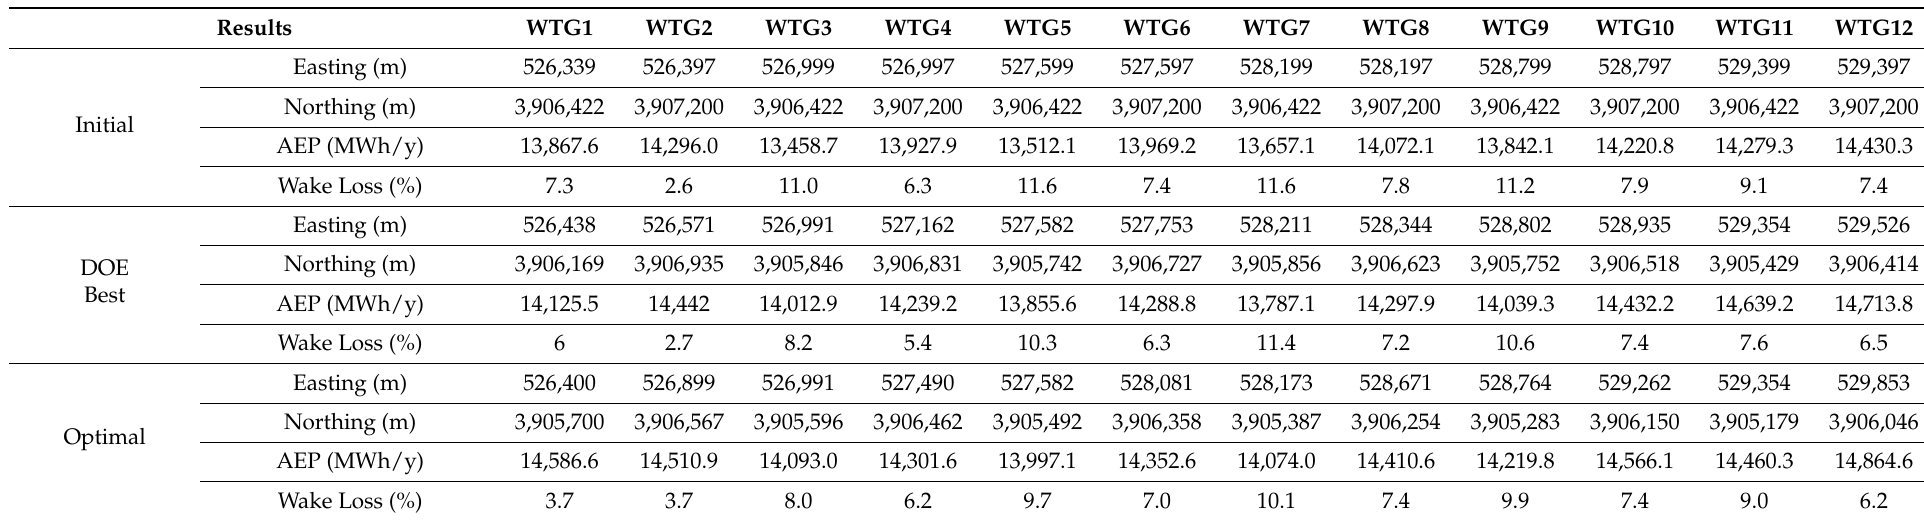
Table 5. Results of calculated annual energy for each of 12